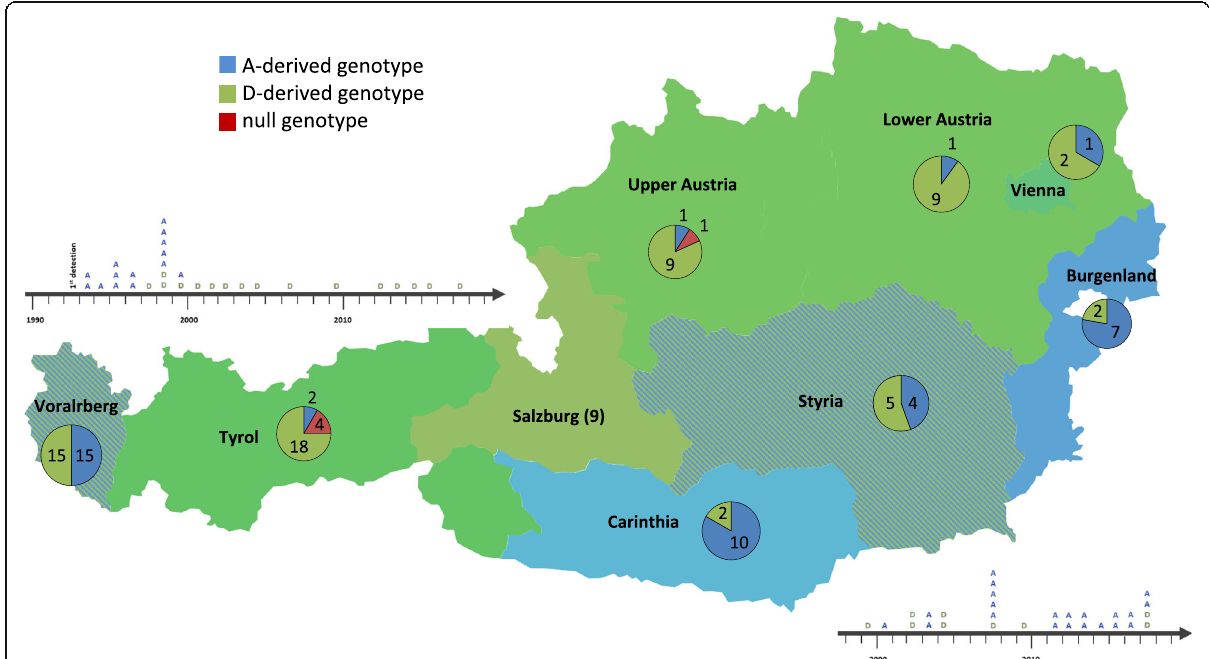
Fig. 5 Prevalence of A- and D-derived genotypes in Austria in the timeframe 1993 – 2017. Pie charts denote the number of isolates of each genotype recovered in each federal state. If only one genotype was detected, the number of corresponding isolates is indicated between parentheses after the federal state name. The null PCR genotype is indicated in red. Federal states are hue-colored according to the dominant archetypal genotype recovered and its prevalence. The left and right timelines represent the succession of the isolate genotypes in the federal state of Vorarlberg and in southeastern Austria (Carinthia, Styria and Burgenland),